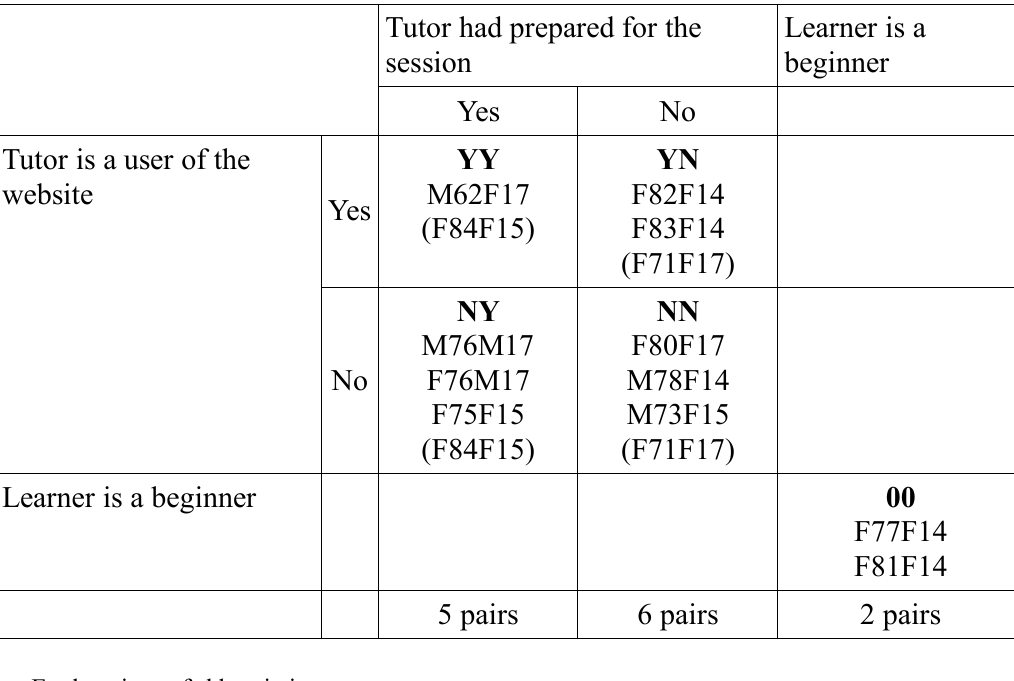
Table 3 . Tutors’ profiles by subgroup. Pairs who had sessions with one part of one type and the other part of another type are in